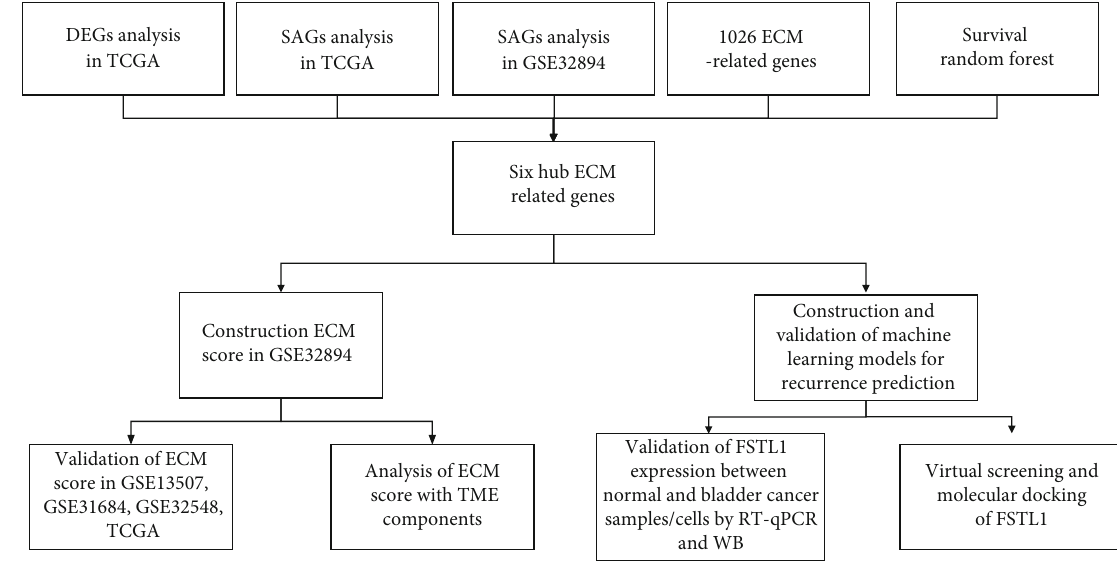
Figure 1: The fl owchart of this